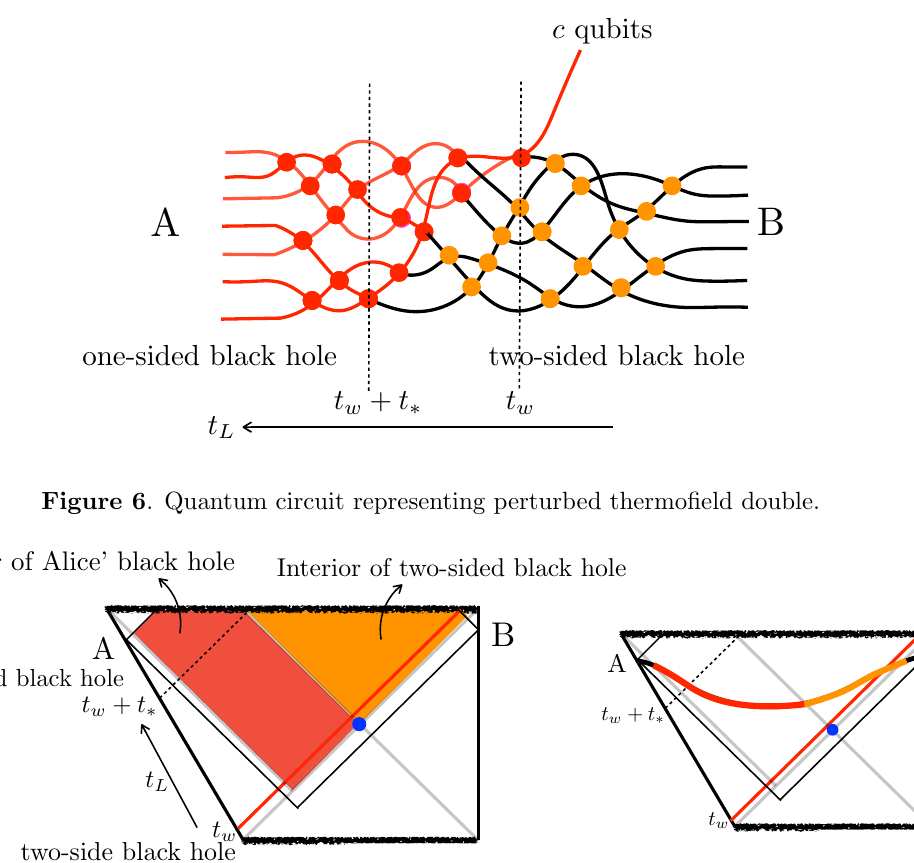
Figure 7 . Perturbed thermo(cid:12)eld double. The blue dot is the RT surface. The orange region is the interior of a two-sided black hole and depends on both A and B. The red region is the interior of Alice’s black